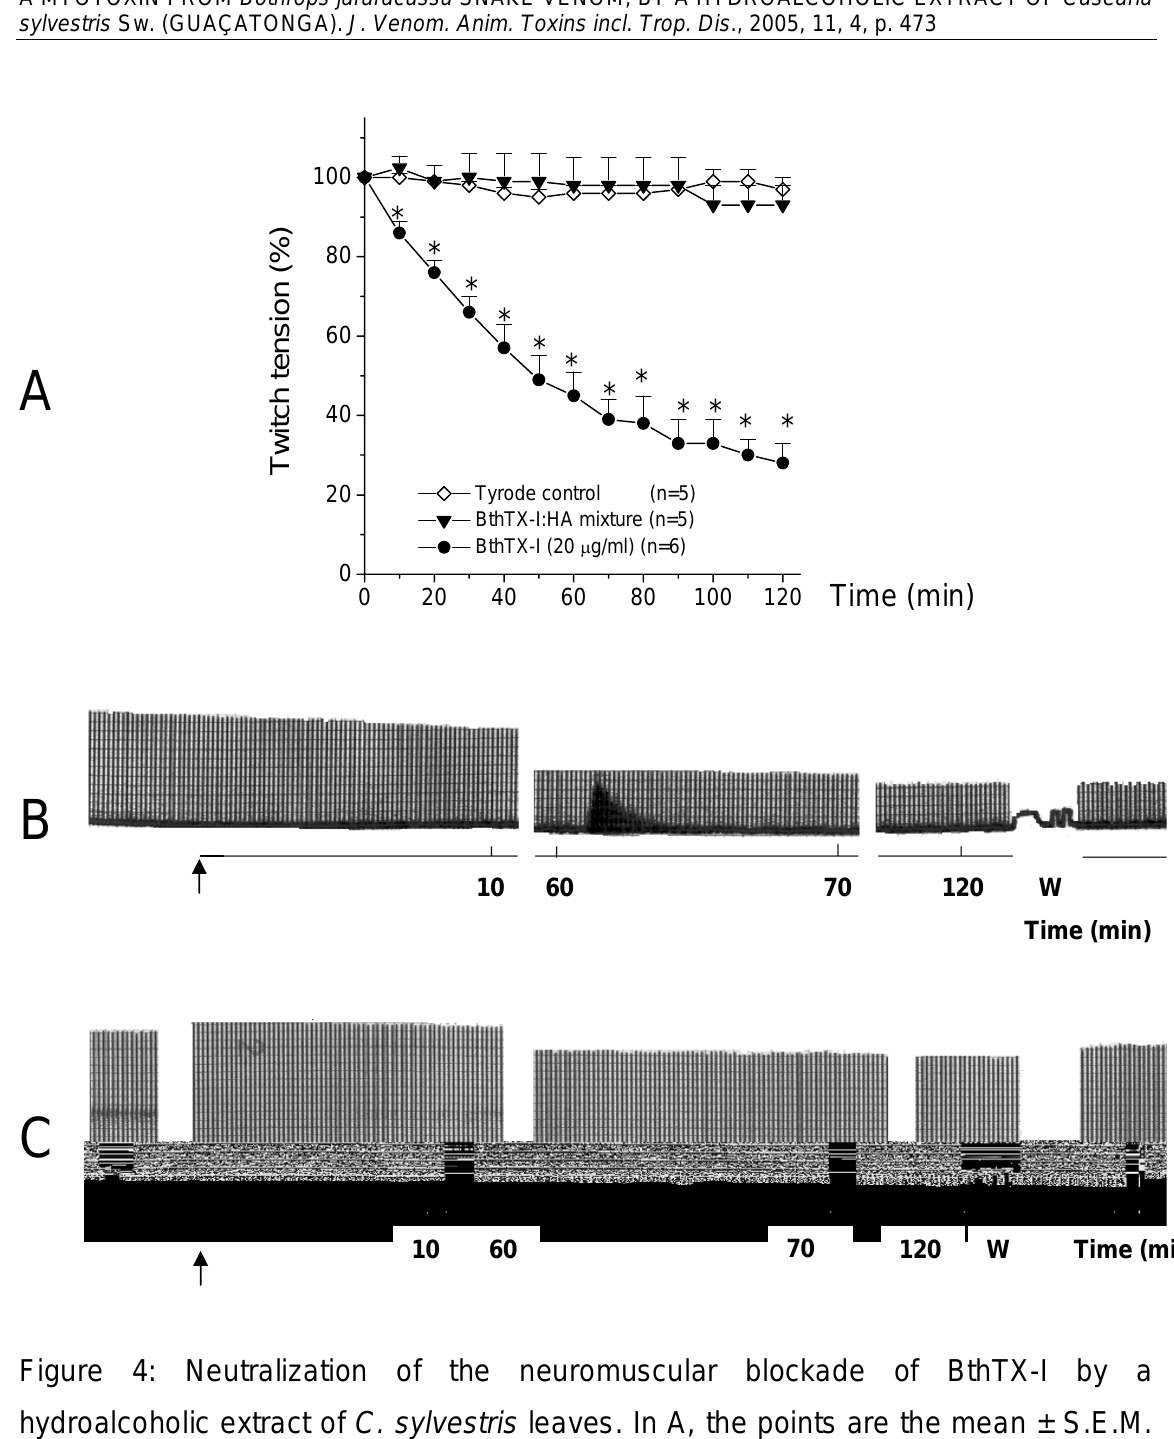
Figure 4: Neutralization of the neuromuscular blockade of BthTX-I by